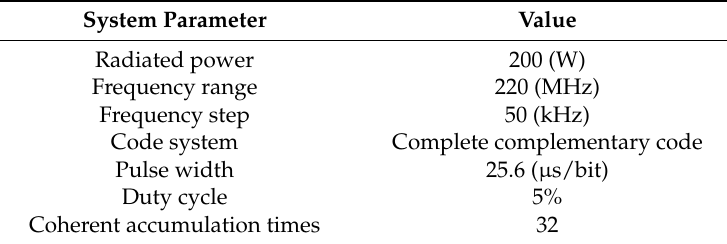
Figure 3. Workstation distribution map. Table 2. Parameters of the experimental system.